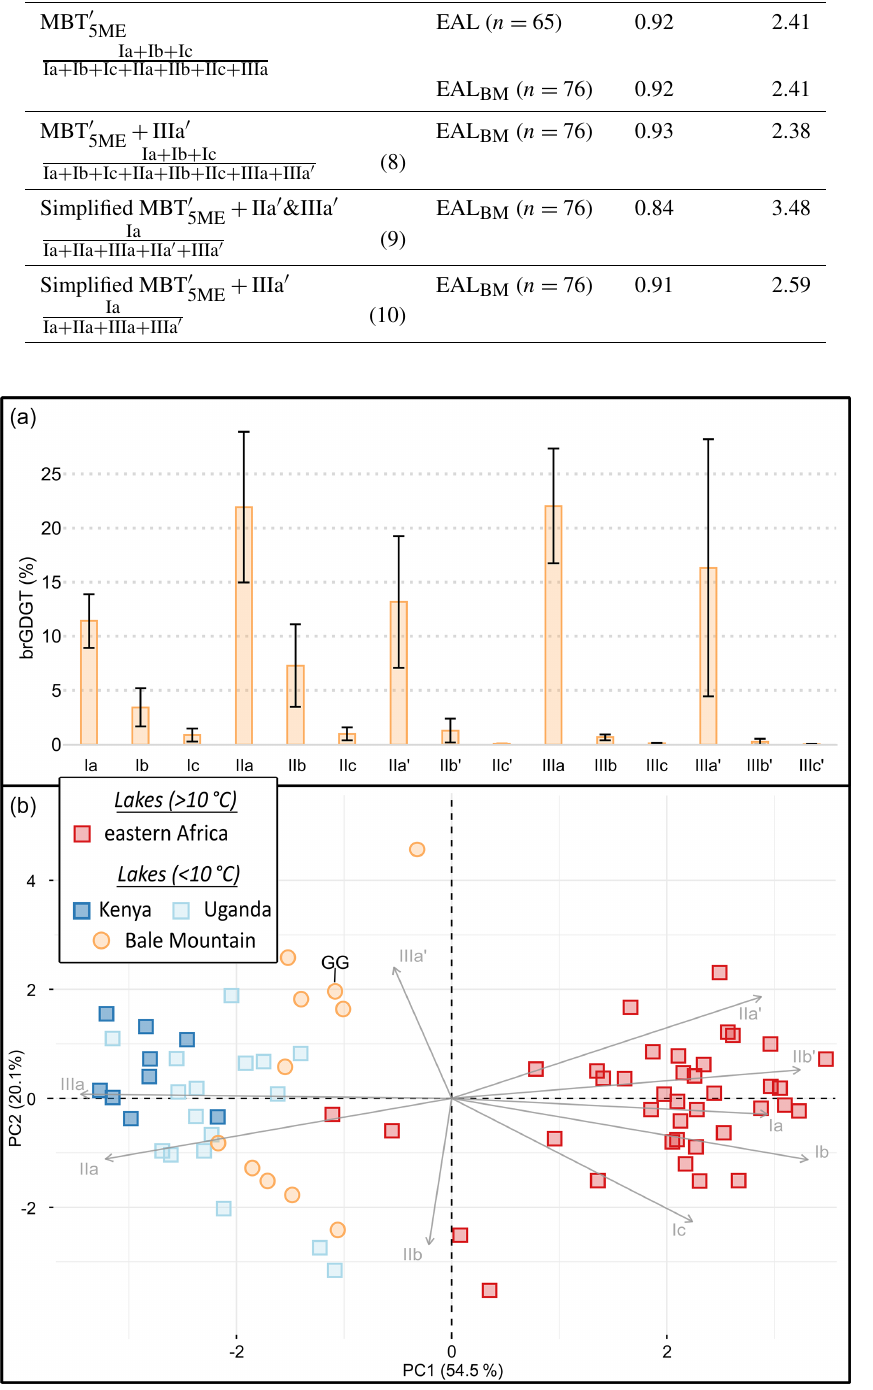
Figure 2. (a) Bar plot of average brGDGT percentages in Bale Mountains lake surface sediments (Baxter et al., 2019), with standard deviation plotted as error flags, and (b) PCA of brGDGTs of eastern African lakes with regional pattern; data from Russell et al. (2018) and Baxter et al. (2019) – lakes > 10 ◦ C (red) and lakes < 10 ◦ C (Bale Mountains – orange, Kenya – blue, and Uganda – light blue); Garba Guracha